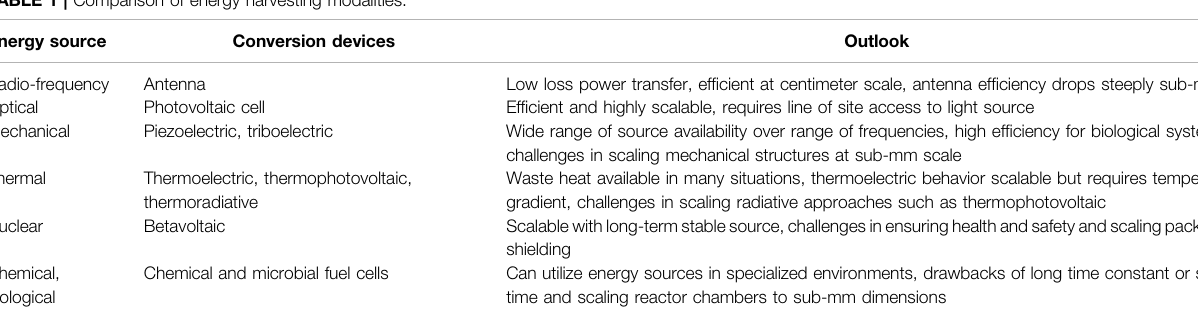
TABLE 1 | Comparison of energy harvesting